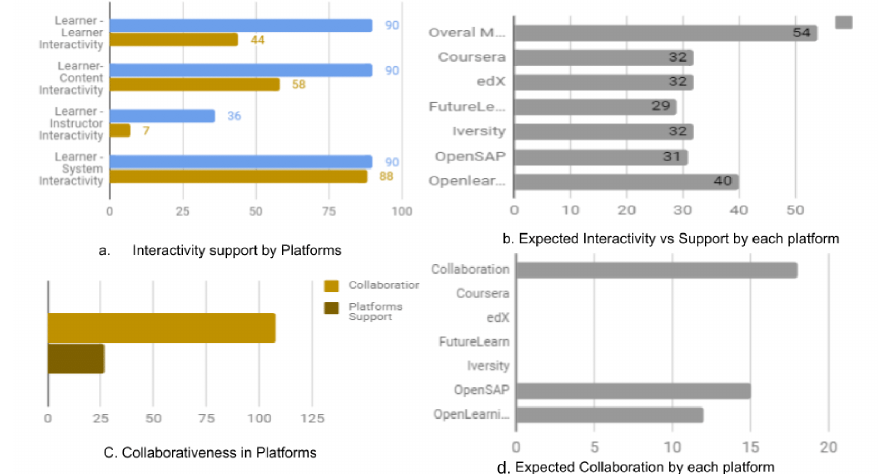
Fig. 3. Overall collaboration and Interactivity measurements: a) Blue bar indicate the best case of interactivity in 6 platforms (i, e for learner to learner interactivity 30x3) and brown indicate the measurement through evaluation in the matrix. b) Top bar is the benchmark for expected interactivity and each platforms interactivity level is indicated in below bars. C) Similar to Interactivity, Collaboration matrix has the expected and evaluators has indicated the level which supported- this indicate collaboration is always at very low than expected. d) Explains the expected Collaboration level, and how much sup- ported by each platform in comparison to 6 platforms we